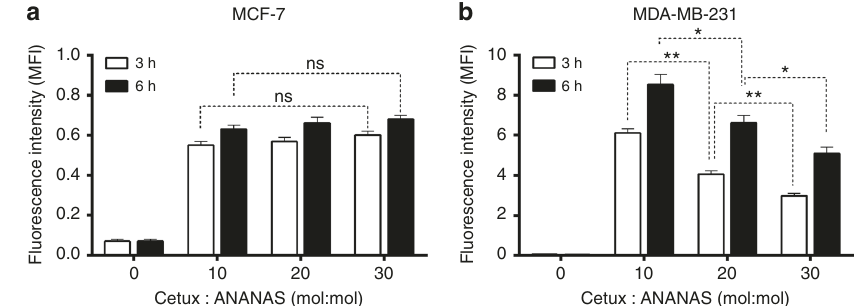
Fig. 2 Cell targeting by formulations with different Cetux/ANANAS molar ratio. Fluorescence intensity associated to MCF-7 or MDA-MB-231 cells after 3 and 6 h incubation with ANANAS/Atto488 formulations (7.5 μ g/mL) at different Cetuximab:ANANAS molar ratio. Median fl uorescence intensity (MFI) values were normalized for the ANANAS-Atto488 loadings (Supplementary Table 1). Data presented as mean ± SEM of three independent experiments (each in triplicate): * p < 0.05, ** p < 0.01 (paired t test)